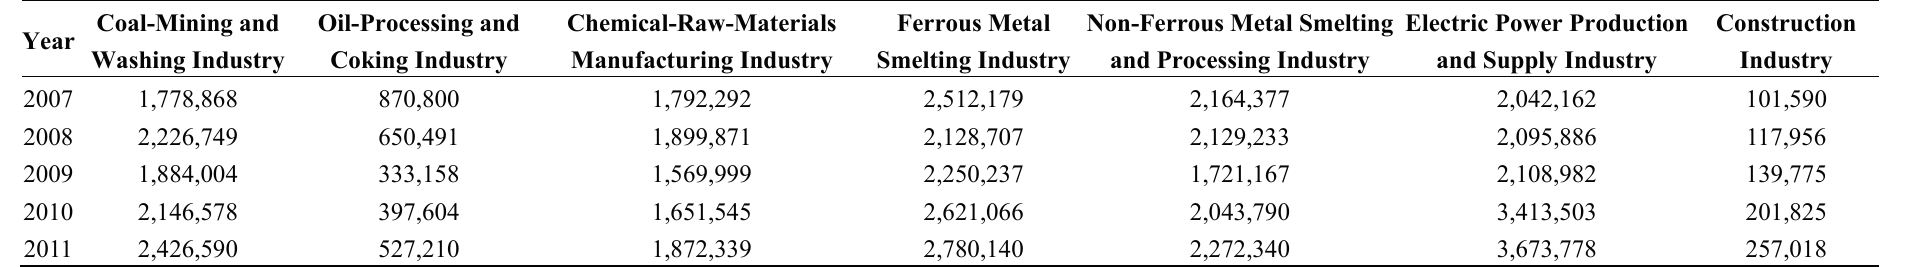
Table 16. The total carbon emissions of industries in Shanxi Province from 2007 to 2011 (10 thousand tons). Sources: Calculating according to the data from